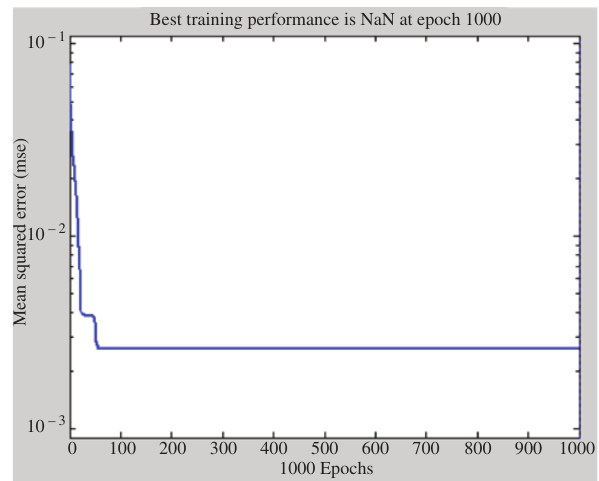
Figure 17: Performance Plot for